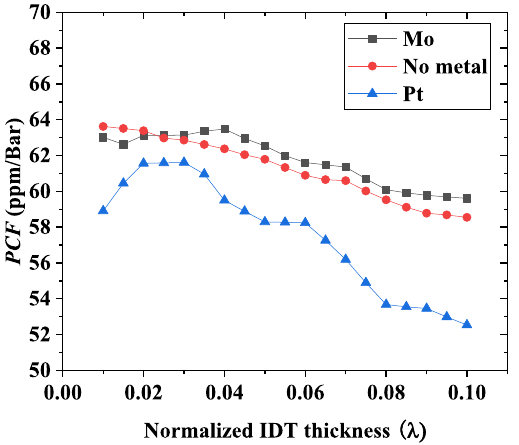
Figure 5. PCF for the different metal layer materials as a function of normalized IDT thickness.